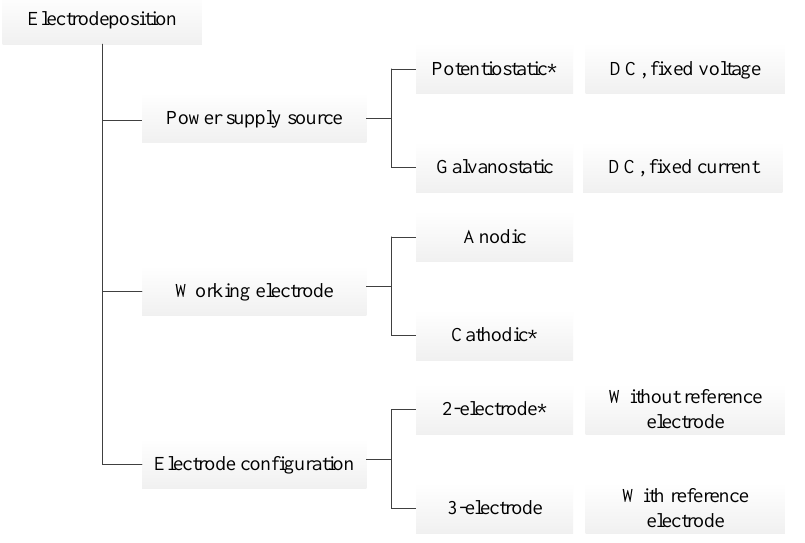
Figure 1. The main categories of electrodeposition technique.